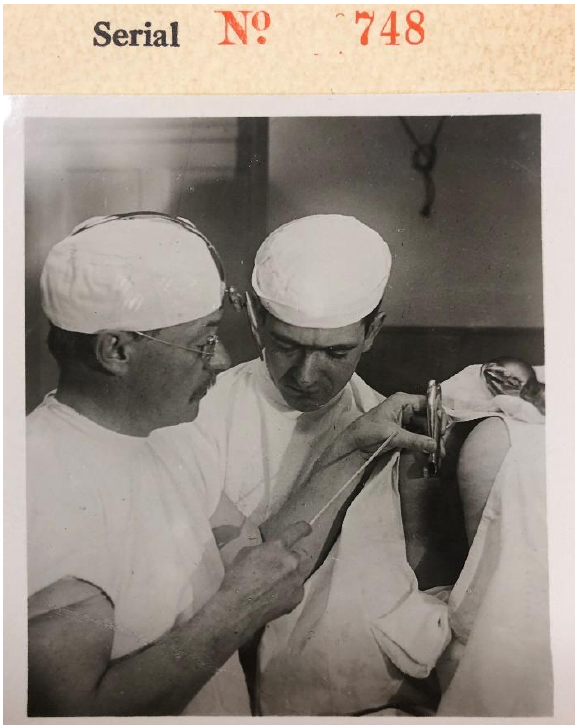
Figure 2 Dr. Howard A. Kelly (on the left). Image provided courtesy of the Robert L. Brown History of Medicine Collection, University at Buffalo